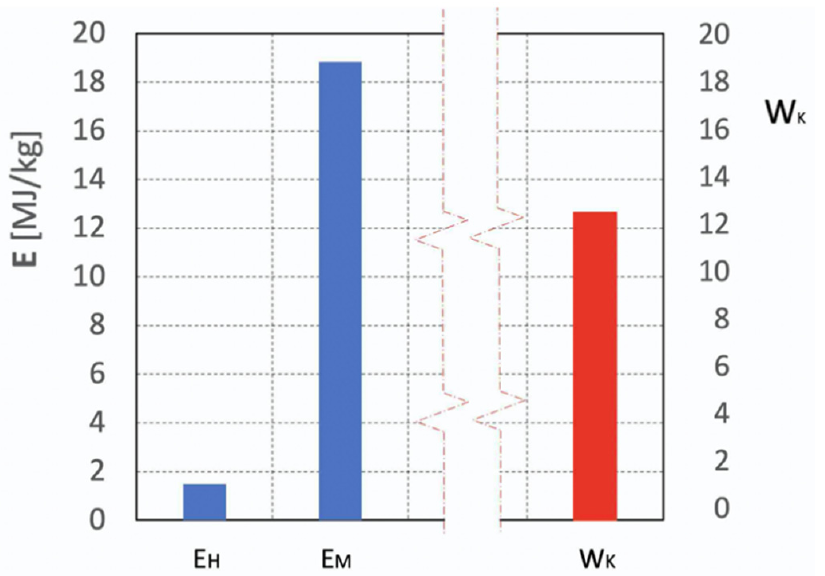
Figure 10. Specific energy consumption of hard coal comminution to the level of a = 35.9 µ m performed in a hydro-jet mill ( E H ) and ground in a planetary ball-mill, type PM 100 ( E M ), together with the benefit index ( W K ).